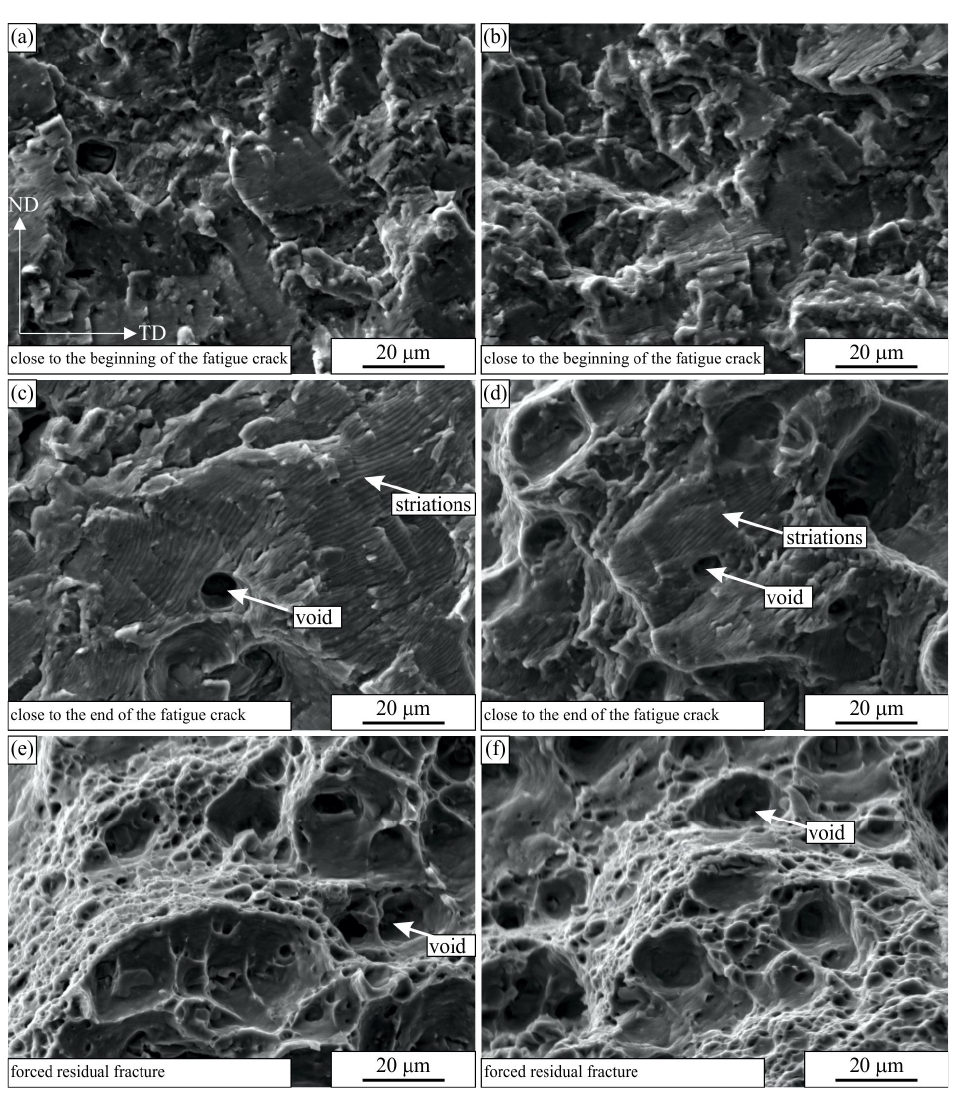
Figure 10. The secondary electron micrographs of the fractured surfaces of the fatigue samples tested in the longitudinal layout: ( a , c , e ) SV 15 (131,581 cycles to failure), ( b , d , f ) SV 19 (19,392,180 cycles to failure). The orientation of all images is the same. The RD direction is perpendicular to the images.